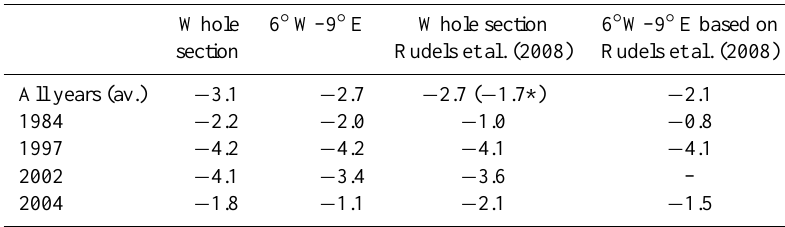
Table 7. Net volume transports at 79 ◦ N from zonal sections and from Rudels et al. (2008). Full section and from 6 ◦ W to 9 ◦ E. Negative transports are southward Whole section Rudels et al. (2008) Rudels et al. (2008) All years